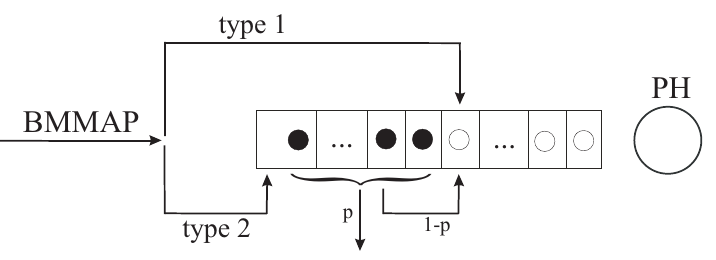
Figure 1. Structure of the